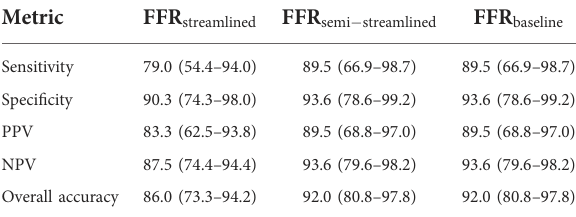
( Figure 5D ). The average percentage discrepancy compared to FFR baseline was 3.3% for FFR semi (cid:1) streamlined and 5.7% for FFR streamlined .